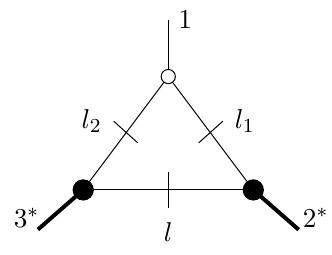
Figure 8 . On-shell diagram with o(cid:11)-shell vertexes for A (cid:3)